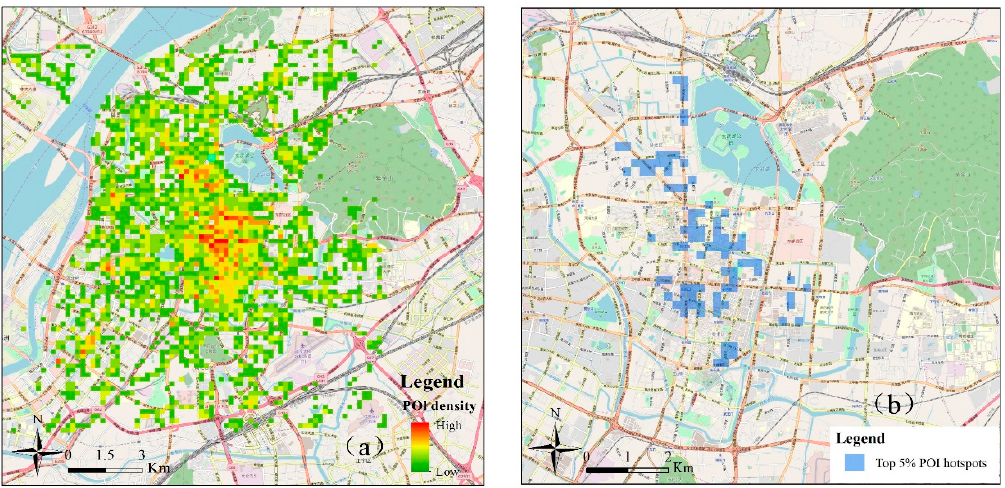
Figure 12. ( a ) Spatial distribution of POI density within urban areas of Nanjing; ( b ) the identified POI hotspots based on the top 5% high density value.